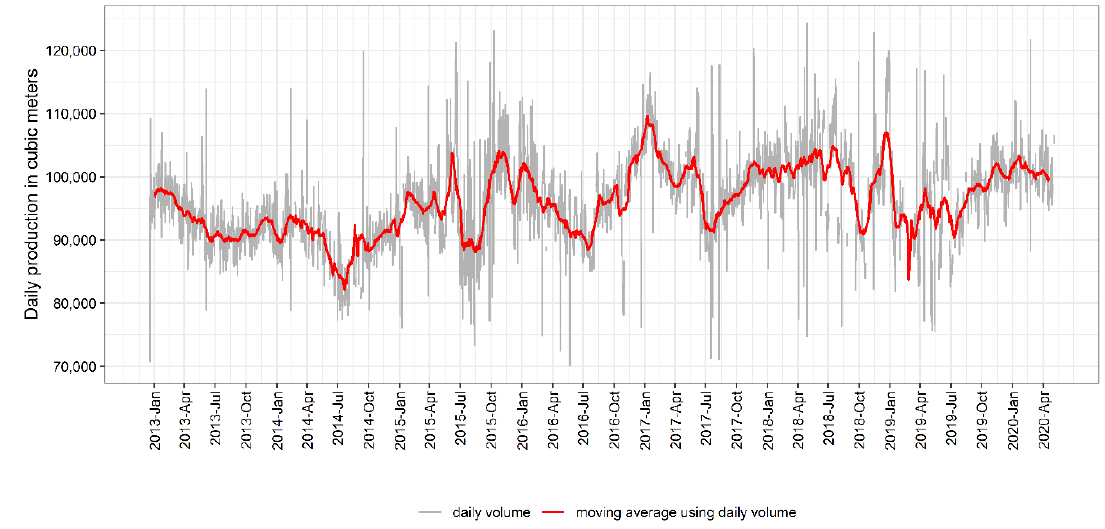
Figure 2. Daily water production of CILE in m 3 with a 31-day centered moving average line.